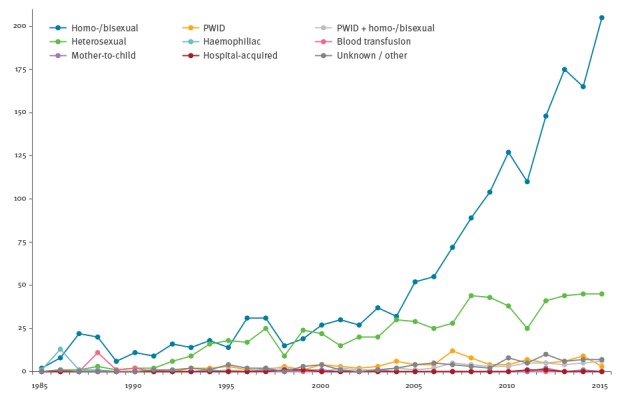
Annual number of newly diagnosed HIV infections among Czech citizens and residents, by transmission category, Czech Republic, 1985–2015